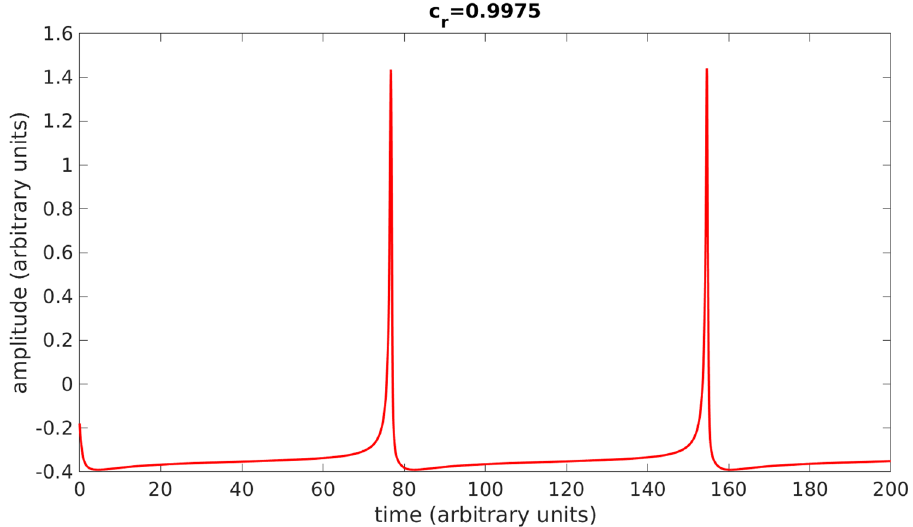
Figure 13. The amplitude and phase of a single mode for c r = 0.9975